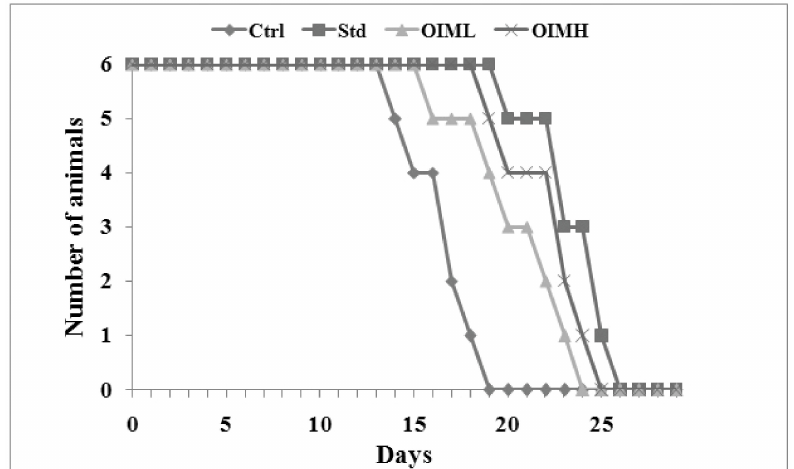
Figure 3. Effect of methanolic extract of O. indicum Vent. (OIM) on the average survival period of ascites tumor-bearing animals. Ctrl—untreated negative control; Std—positive control, treated with cyclophosphamide (i.p.) at 10 mg/kg b.wt.; OIML—low-dose group treated with OIM at dosage 200 mg/kg, and OIMH—high-dose group treated with OIM at dosage 400 mg/kg